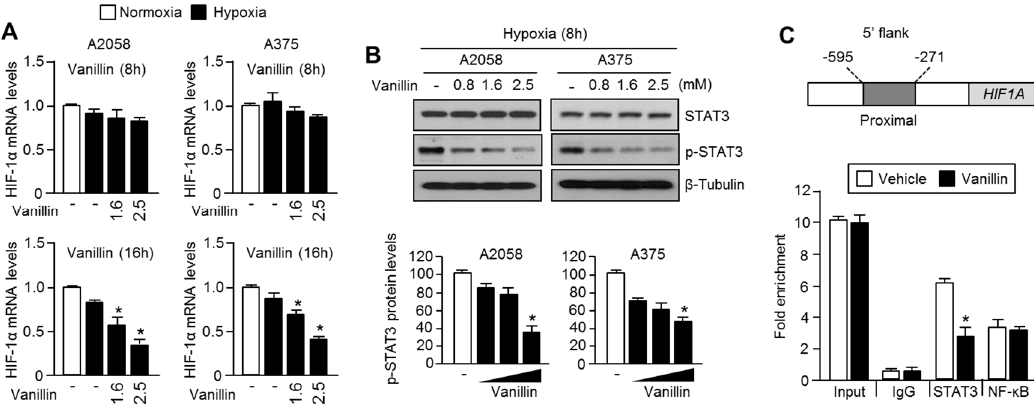
Figure 4. Vanillin decreases HIF-1 α mRNA expression by inhibiting signal transducer and activator of transcription 3 (STAT3). ( A ) Vanillin decreases HIF-1 α mRNA levels in A2058 and A375 human melanoma cells. Cells were incubated in the absence or presence of vanillin for 8 h or 16 h under hypoxic condition. HIF-1 α mRNA levels were measured using quantitative real time (RT)-PCR. Values represent the mean ± SD of three independent experiments performed in duplicate; * p < 0.05; ( B ) Vanillin decreases STAT3 phosphorylation under hypoxia. A2058 and A375 melanoma cells were incubated with vanillin for 8 h under hypoxia. STAT3 protein levels were detected by immunoblotting, and then protein levels were quantified using Image J software. Values represent the mean ± SD of three independent experiments performed; * p < 0.05; ( C ) Vanillin causes dissociation of STAT3 from the HIF-1 α promoter region. A2058 cells were incubated with 2.5 mM of vanillin for 8 h and then fixed with formalin. Chromatin was immunoprecipitated with non-immunized serum (IgG) or the antisera as indicated. The proximal region of HIF-1 α promoter was amplified using quantitative PCR. Values represent the mean ± SD of two independent experiments performed in triplicate; * p < 0.05.